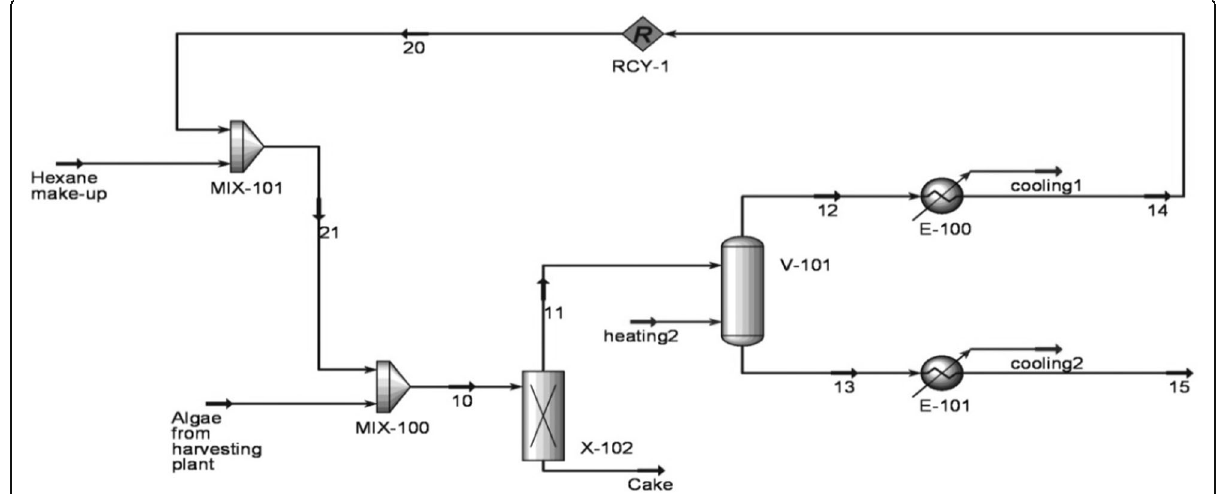
Fig. 3 Extraction of oil flow sheet, where (MIX-100) microalgae/solvent mixer, (MIX-101) recycled/make-up solvent mixer, (X-102) settling tank, (V-